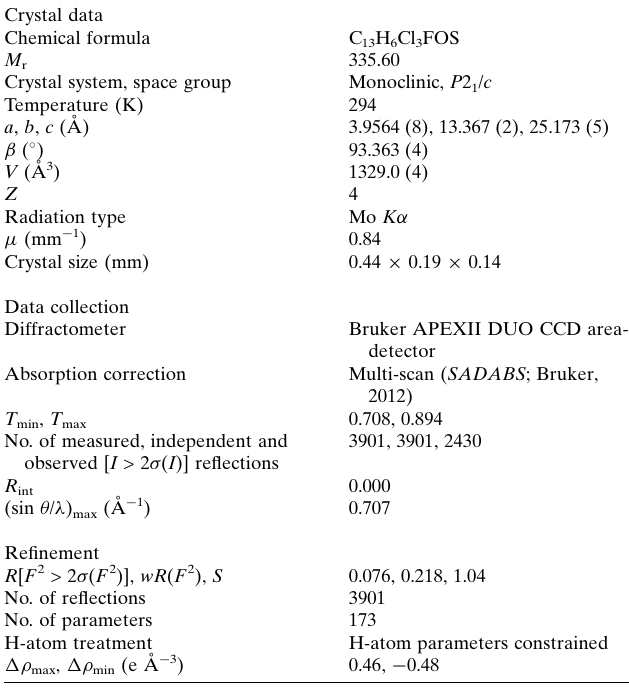
Table 2 Experimental details. Crystal data Chemical